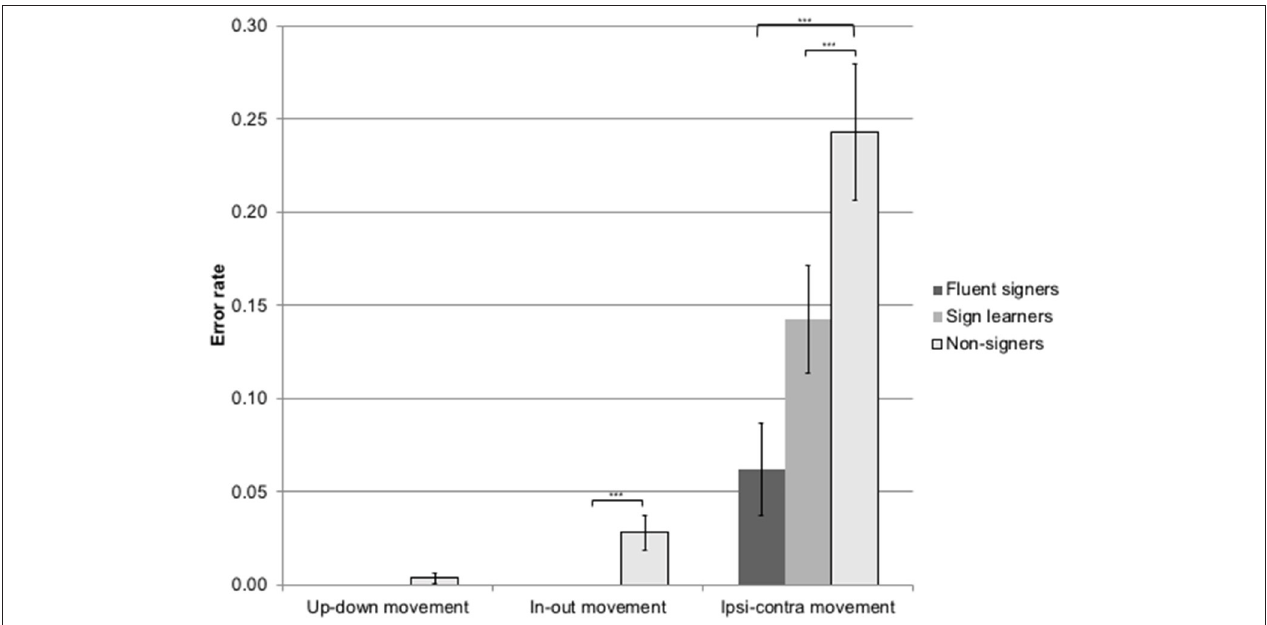
FIGURE 4 | Error rate by movement type for non-signers, sign learners, and fluent signers. *** p < 0.001.